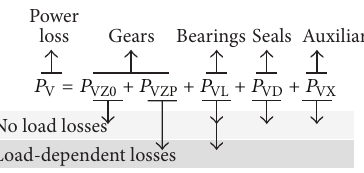
Figure 1: Power loss